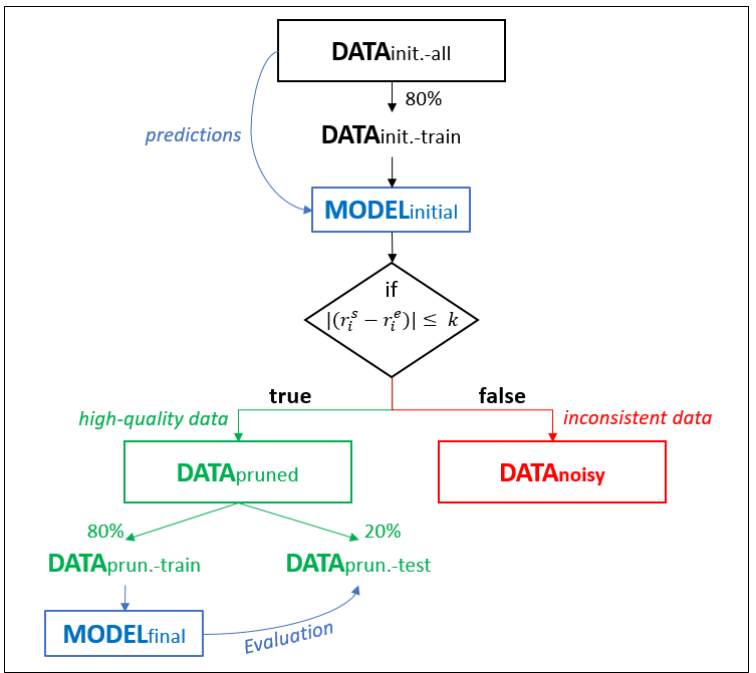
Figure 4. Visualization guide regarding the process, and terminology used, to create a quality inspector model.